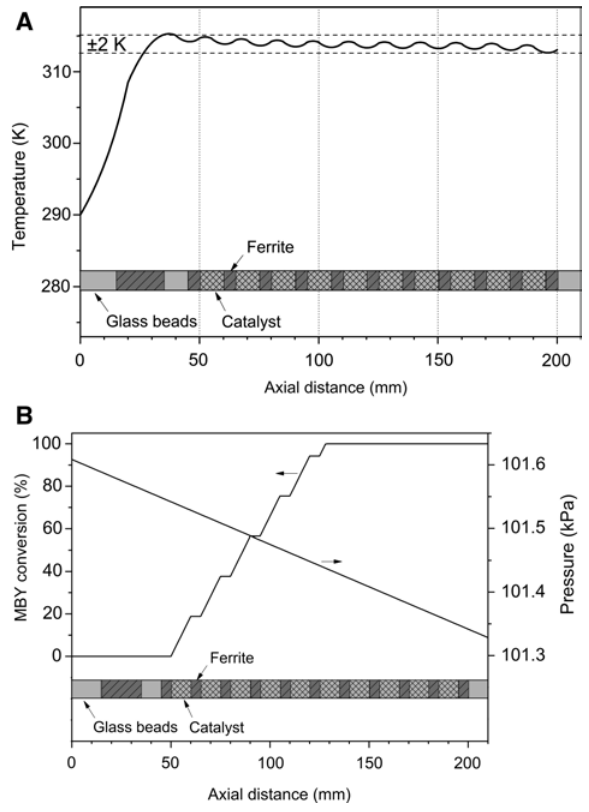
Figure 2: Simulated (A) temperature, (B) 2-methyl-3-butyne-2-ol (MBY) conversion and pressure drop as a function of axial position in the 11 zone micro trickle bed reactor. Liquid flow rate: 0.1 ml/min gas flow rate: 3.0 ml/min (STP) volumetric heat generation rate: 410 kW/m 3